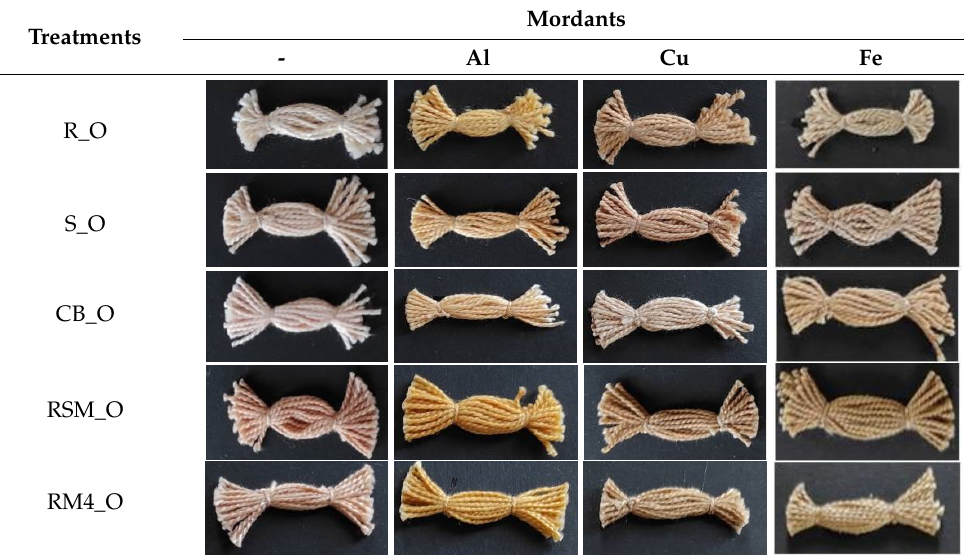
Figure 4. Colour analysis in the a*/b* colour space and objective results of lightness (L*), schroma (C*) and hue (h°) of cotton yarns dyed with onion peel. Table 5. Cotton yarns dyed with onion peel.